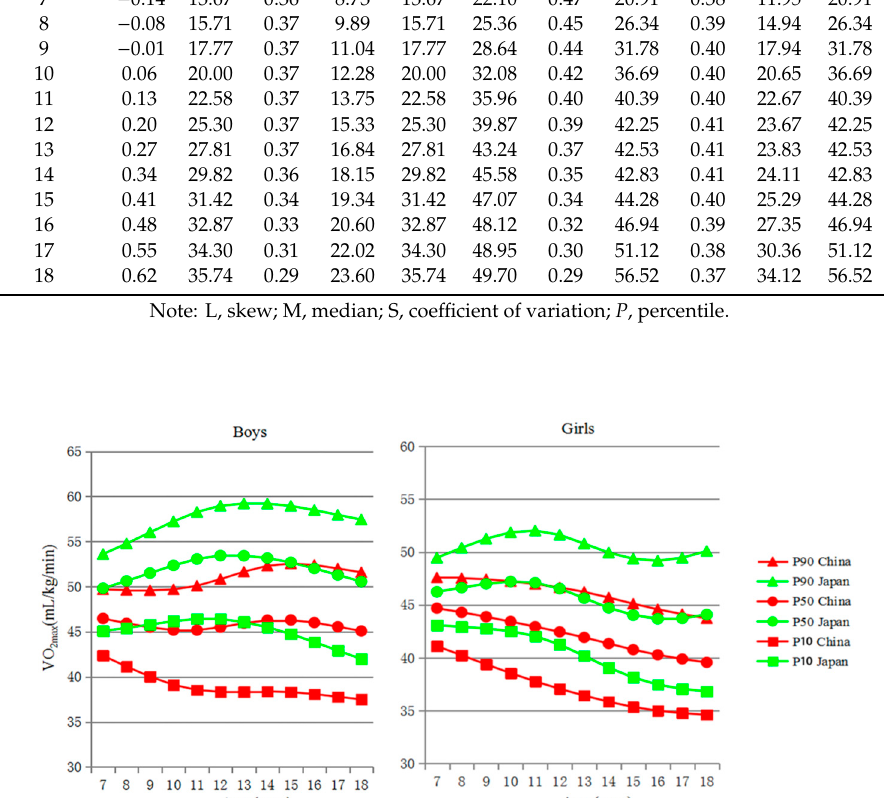
Figure 2. Centile curves for VO 2max values of Chinese and Japanese children and adolescents aged 7–18 years.